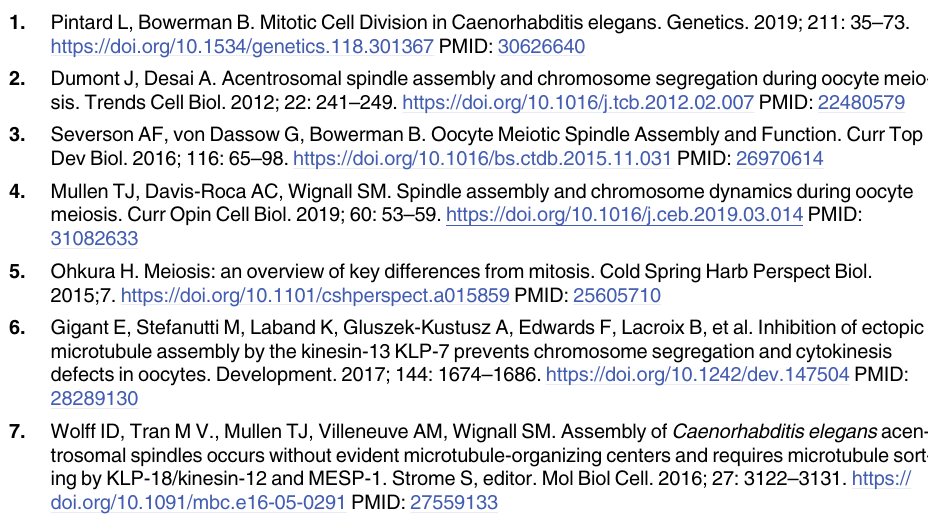
indicated by an orange sphere. Frame rate is 5 frames per second. (MP4) S1 Data. Raw data for timing of temperature shifts during meiosis I in S2 and S13 Figs. (XLSX) S2 Data. Raw data for statistics on chromosome set ratios in Figs 1 and 5. (XLSX) S3 Data. Raw data for quantification of microtubule levels in Fig 3. S4 Data. Raw data for quantifying GFP::ASPM-1 spots in Figs 4 and